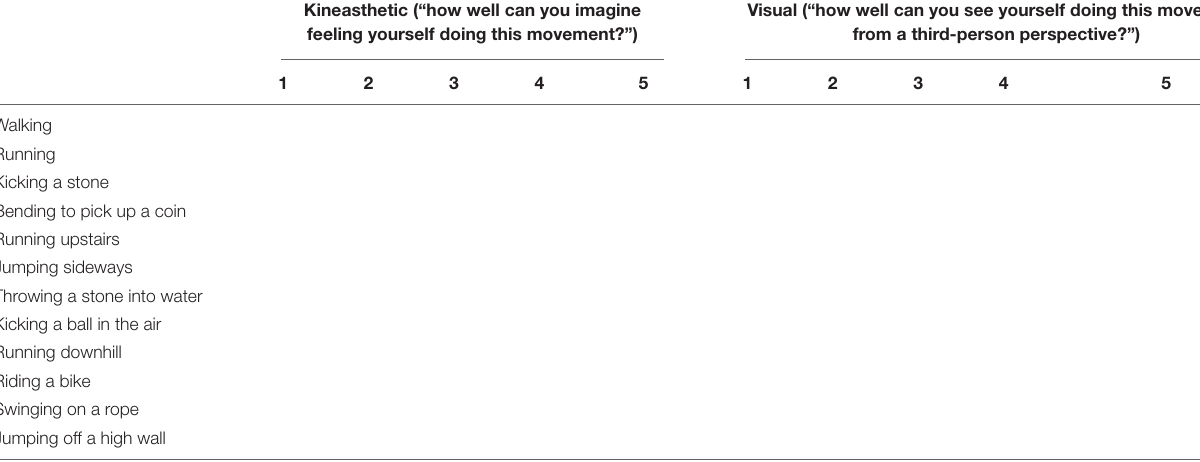
Visual (“how well can you see yourself doing this movement from a third-person perspective?”)